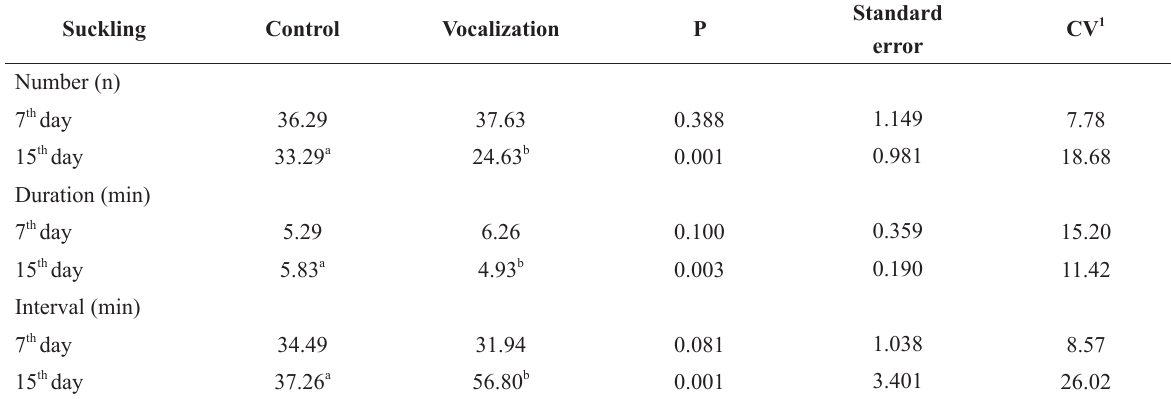
Behavior of suckling piglets due to artificial